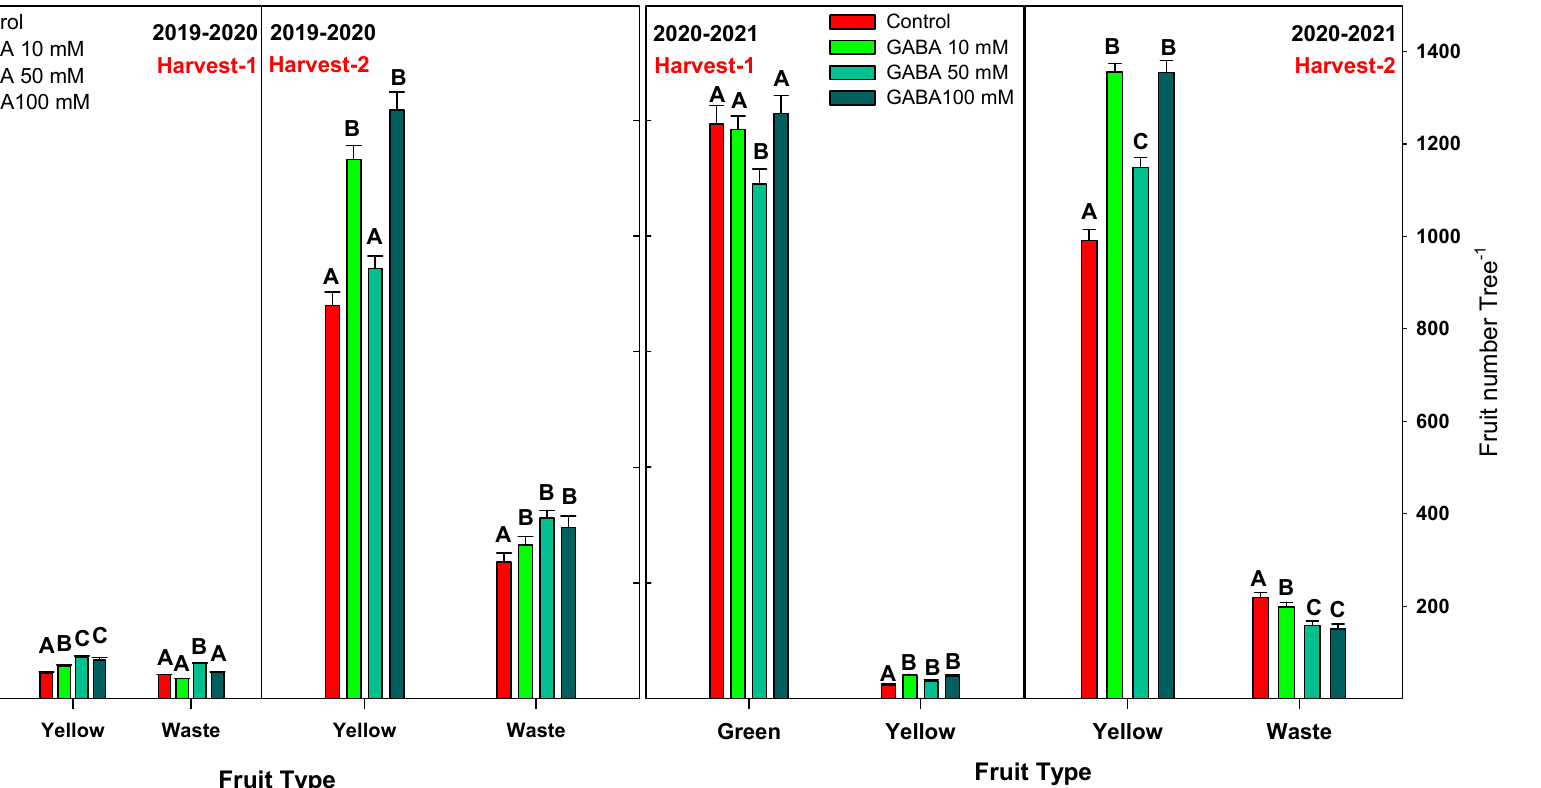
Figure 4. Crop yield (number of fruits tree − 1 ) for the two harvest dates and 2 seasons as affected by GABA treatment and according to different categories. Data are the mean ± SE. Different letters (A, B, and C) on the bars denote significant differences at p < 0.05 among treatments for each fruit type.